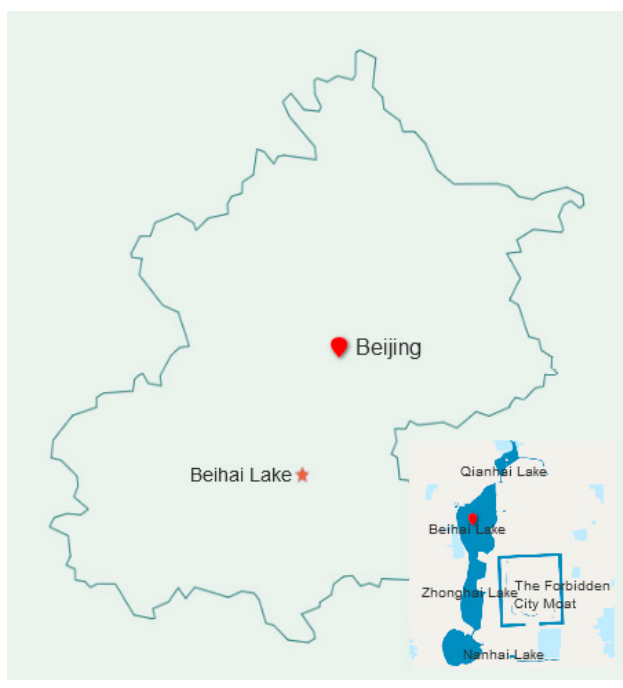
Figure 1. Location map of Beihai Lake in Beijing. 87 Table 1. Basic statistics of the measured water quality variables of Beihai